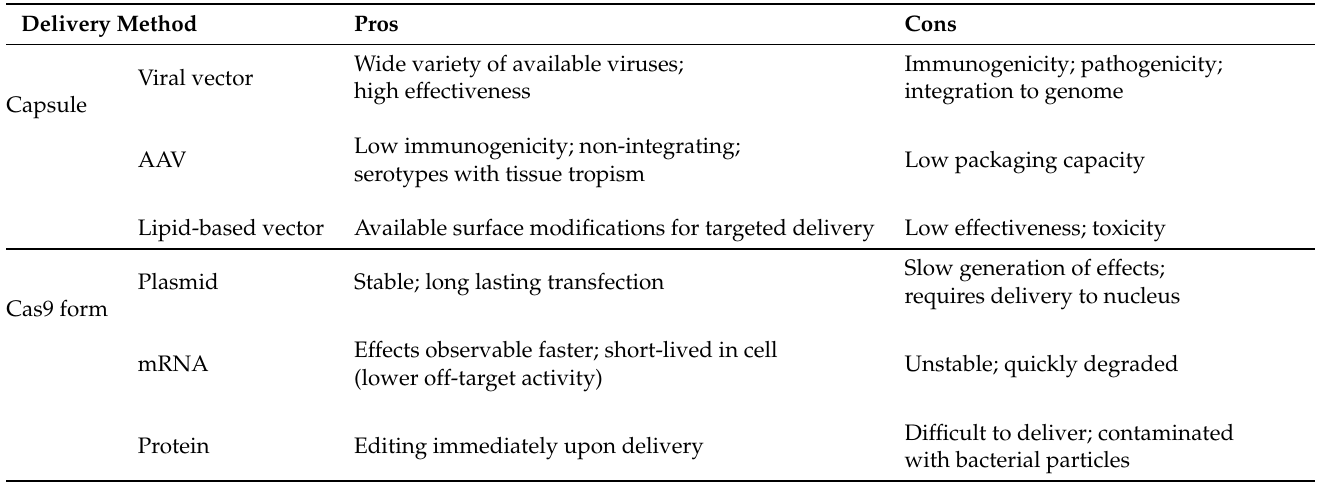
Table 2. Pros and cons of most popular delivery methods